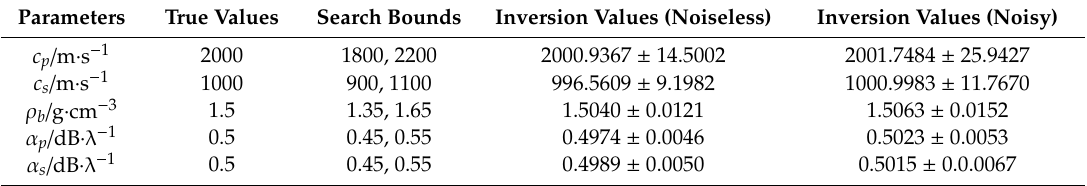
( j ) α p , α s Figure 9. 2D marginal PPDs between different parameters in the noisy sea environment. White dashed lines mark the true values of each parameter in the simulation.